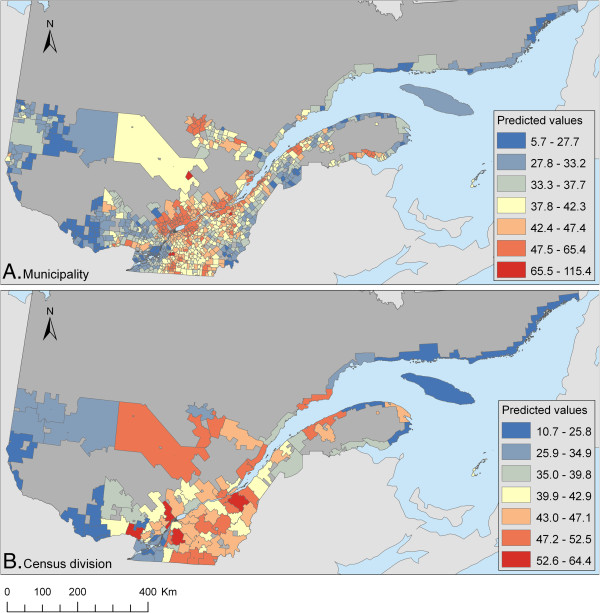
A-B. Predicted incidence of campylobacteriosis. Predicted annual incidence of reported cases of campylobacteriosis per 100,000 people in Quebec (1996–2006) according to a conditional autoregressive (CAR) model at the level of municipality (A) or census division (B). Classification was done using Jenk’s natural breaks. Dark grey areas represent the unpopulated areas, non-organized territories or incompletely enumerated Indian reserves and settlements within Quebec, whereas light grey shows the frontier area of Quebec.